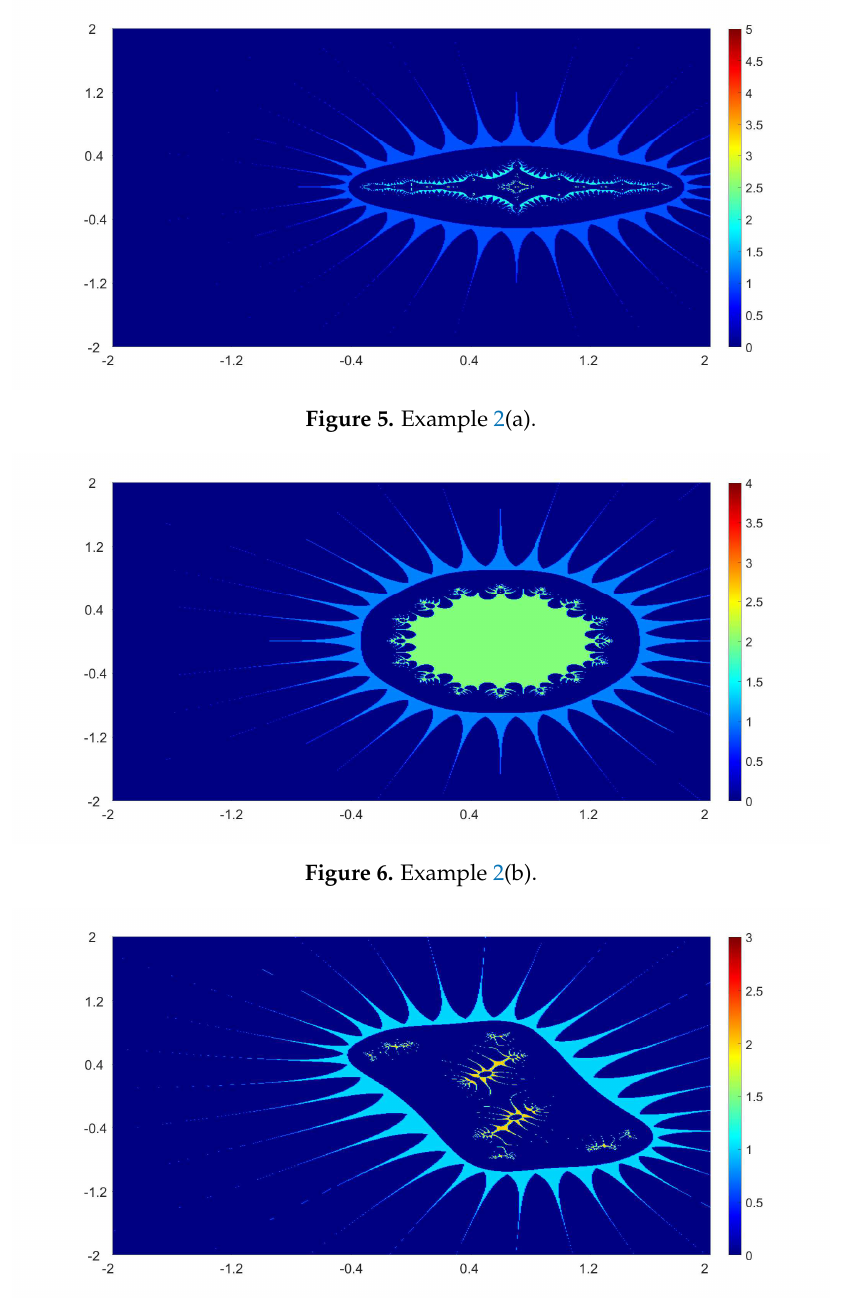
Figure 7. Example